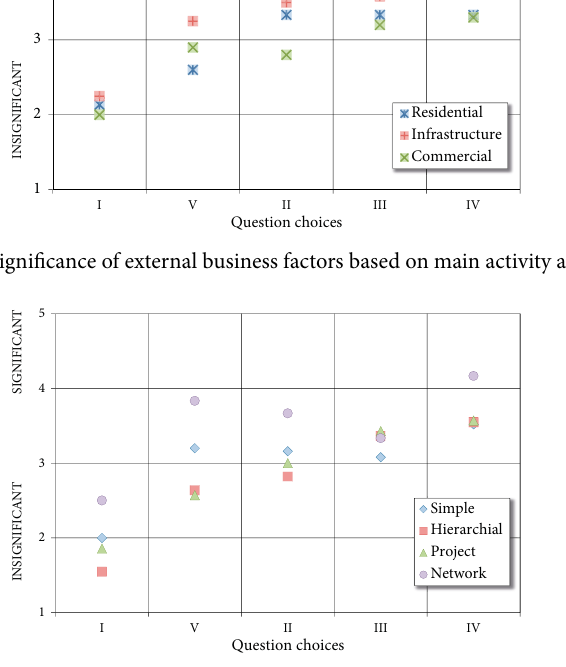
Fig. 10. Significance of external business factors according to organizational